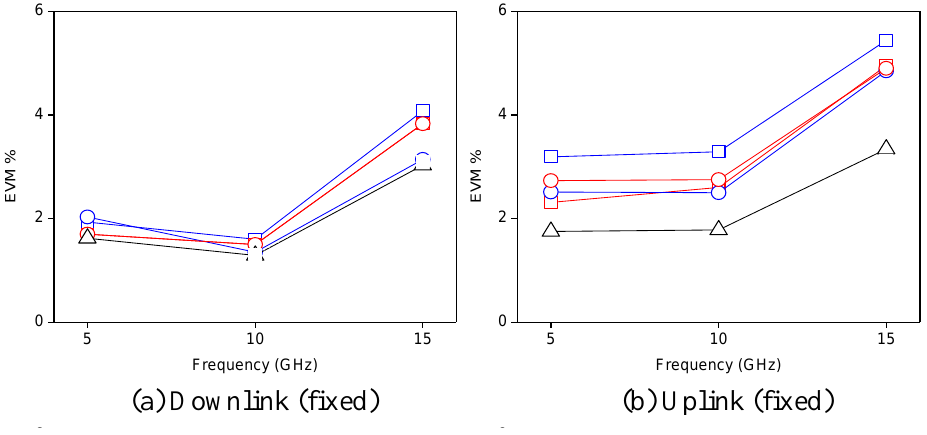
Figure 6. EVM vs. SCM frequency for (a) downlink and (b) uplink transmission in different routing scenarios considering fixed channels λ1 F [scenario 1 (  ) and 2 (  )] and λ3 F [scenario 1 (  ) and 2 (  )]. Optical back-to-back (  ). Note: both extra